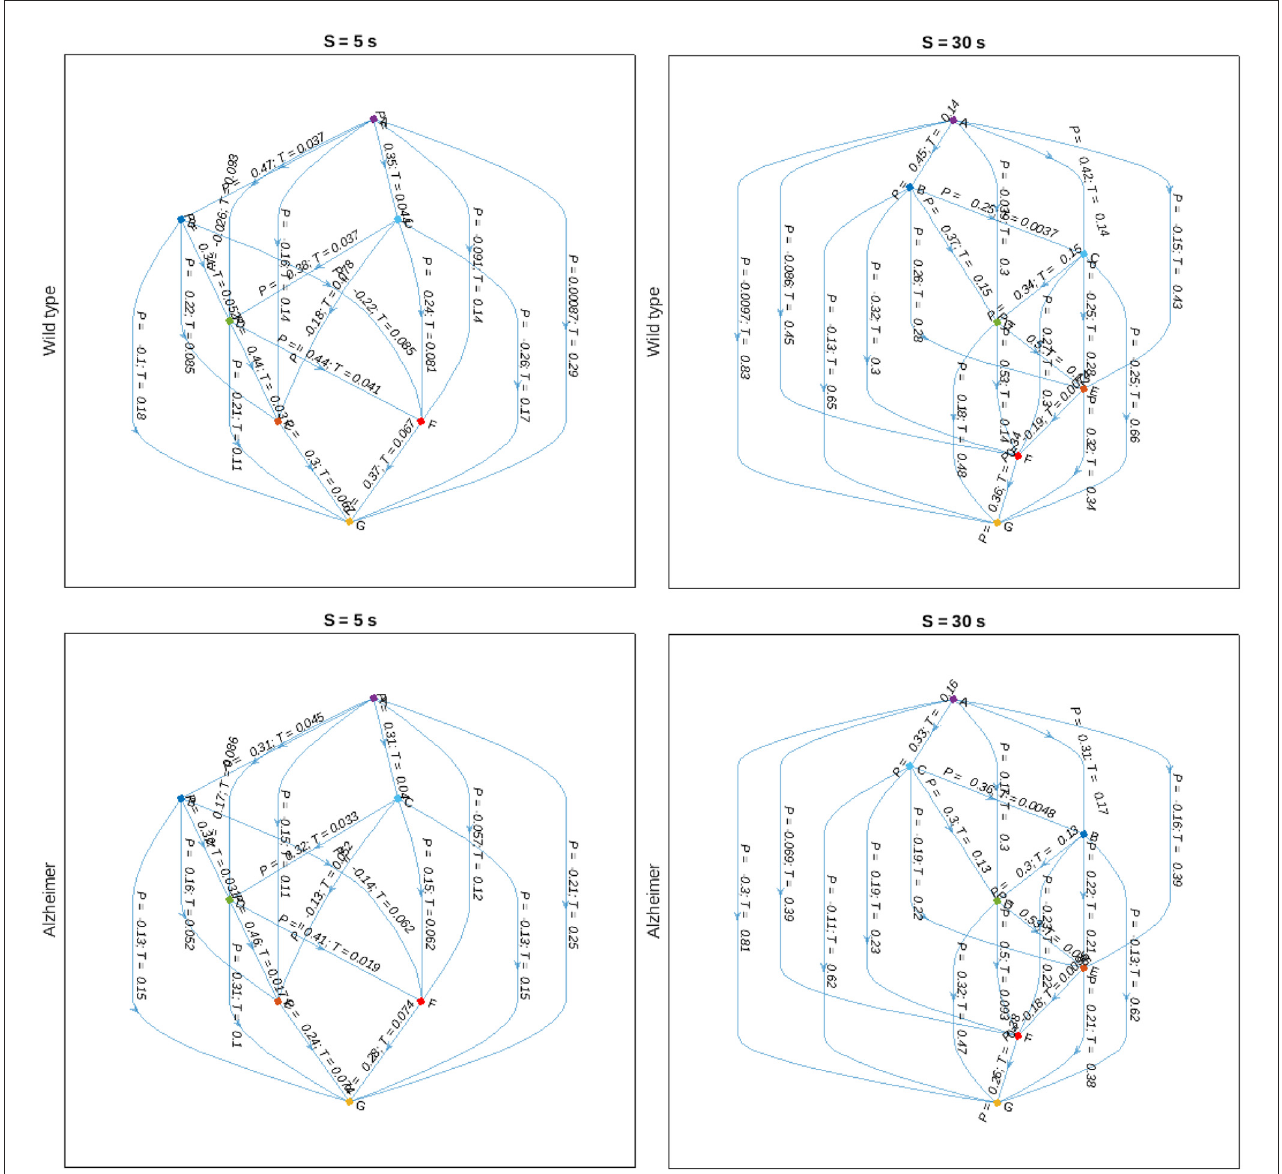
FIGURE8 Graph-based representations of maximum partial correlations P ij between animal body part movements observed at scales S = 5 and 30 s (left, right) and delays T ij corresponding to the positions of the respective cross-covariance maxima for the control and Alzheimer’s disease animal groups (upper, lower) ,